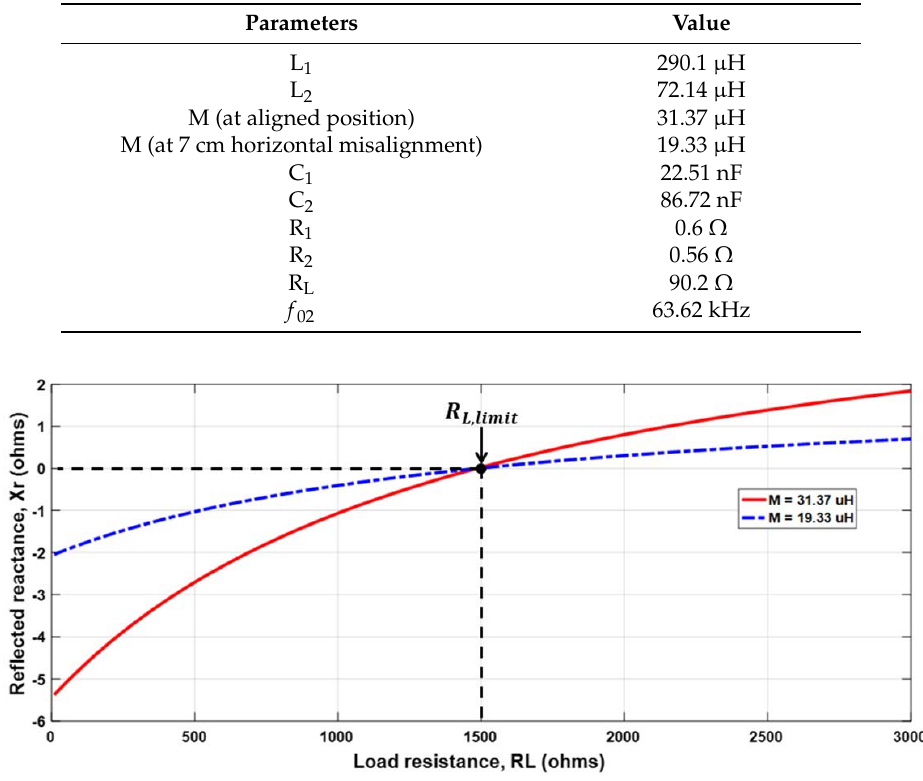
Table 1. Designed circuit parameters.